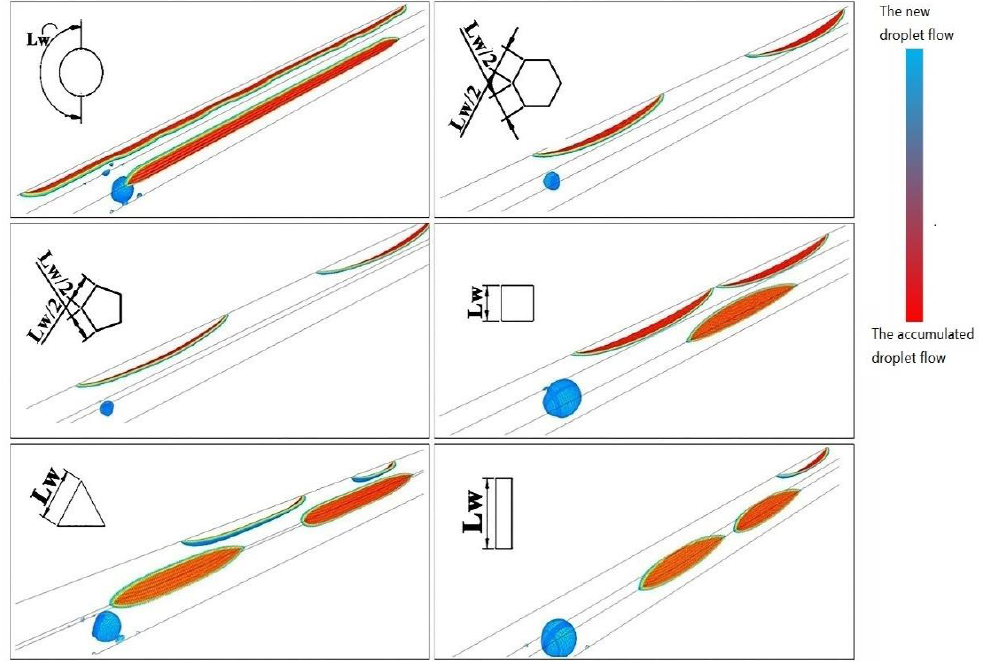
Figure 5. Effect of the pore shape on the flow pattern of liquid water in the channel.